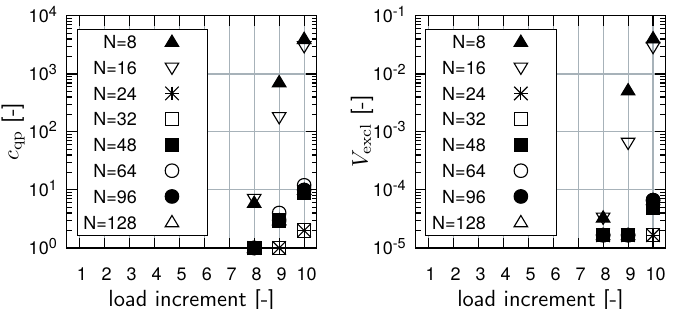
Figure 11. (Left) Number of quadrature points at which the cutoff function φ attains a value less than one. (Right) Relative excluded